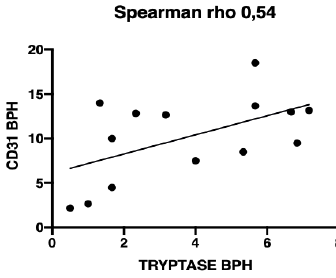
Figure 5. The Spearman’s Rho diagram showing correlation between CD31 immunostaining -based microvessel density (MVD) and tryptase immunostaining-based mast cells density (MCD) in benign prostate hyperplasia (BPH) samples (ρ=0.54 p = 0.041).